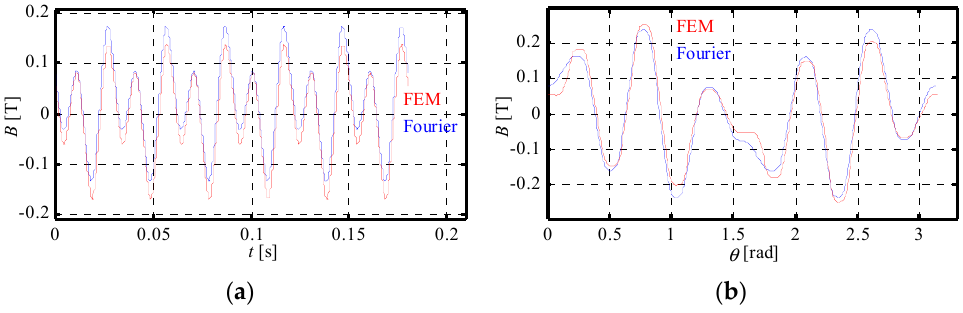
Figure 10. Flux density created by stator coils on the rotor surface of the Qs24p10 machine: ( a ) tem- poral distribution, ( b ) spatial distribution.